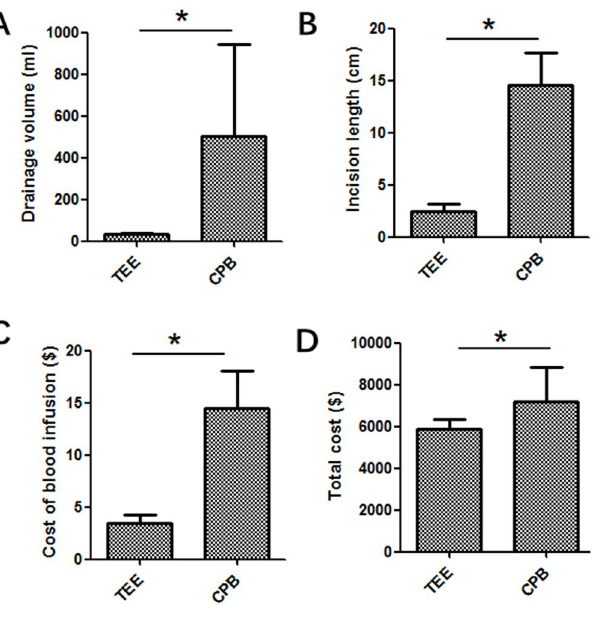
Fig. 3 - Time for chest opening (A), time for chest closing (B), time for operation (C), time for ICU stay (D) and time for hospitalization (E). Mean ± standard deviation. Two groups were compared using independent samples t test, *P<0.05 for statistical differences.